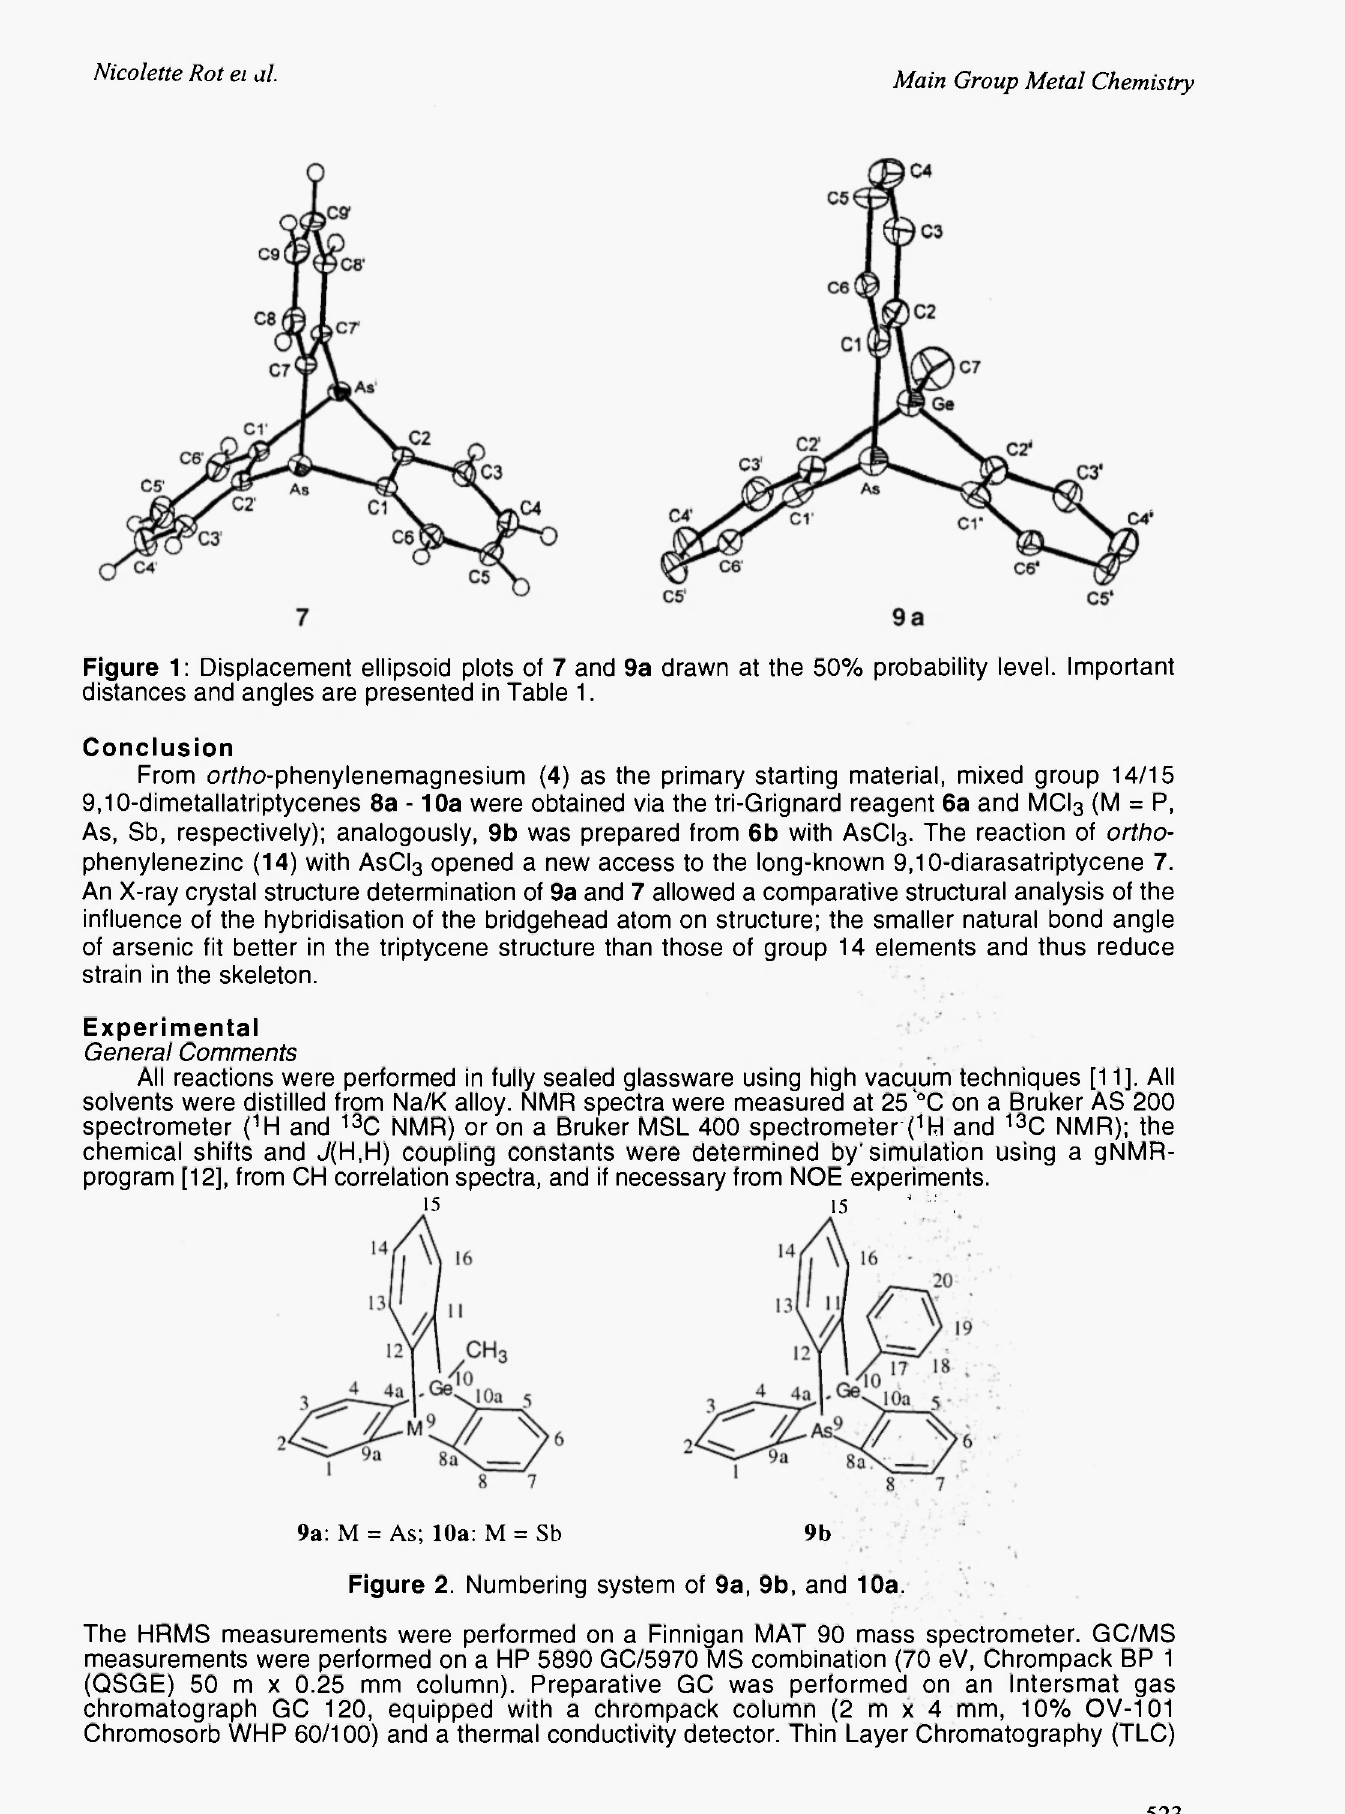
Figure 2. Numbering system of 9a, 9b, and